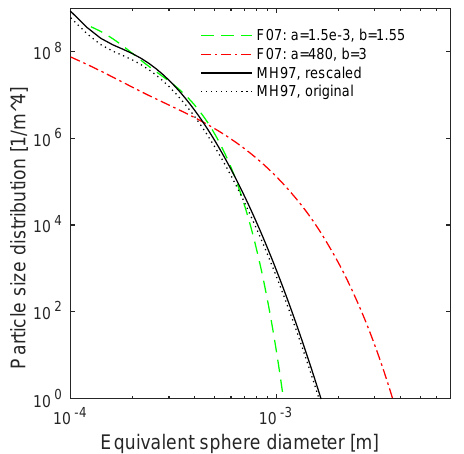
Figure 11. Ice particle size distributions for 0.1gm − 3 , according to Field et al. (2007, F07) and McFarquhar and Heymsfield (1997, MH97). The F07 PSD is converted from d m to d e for two combina- tions of a and b (Eq. 11).